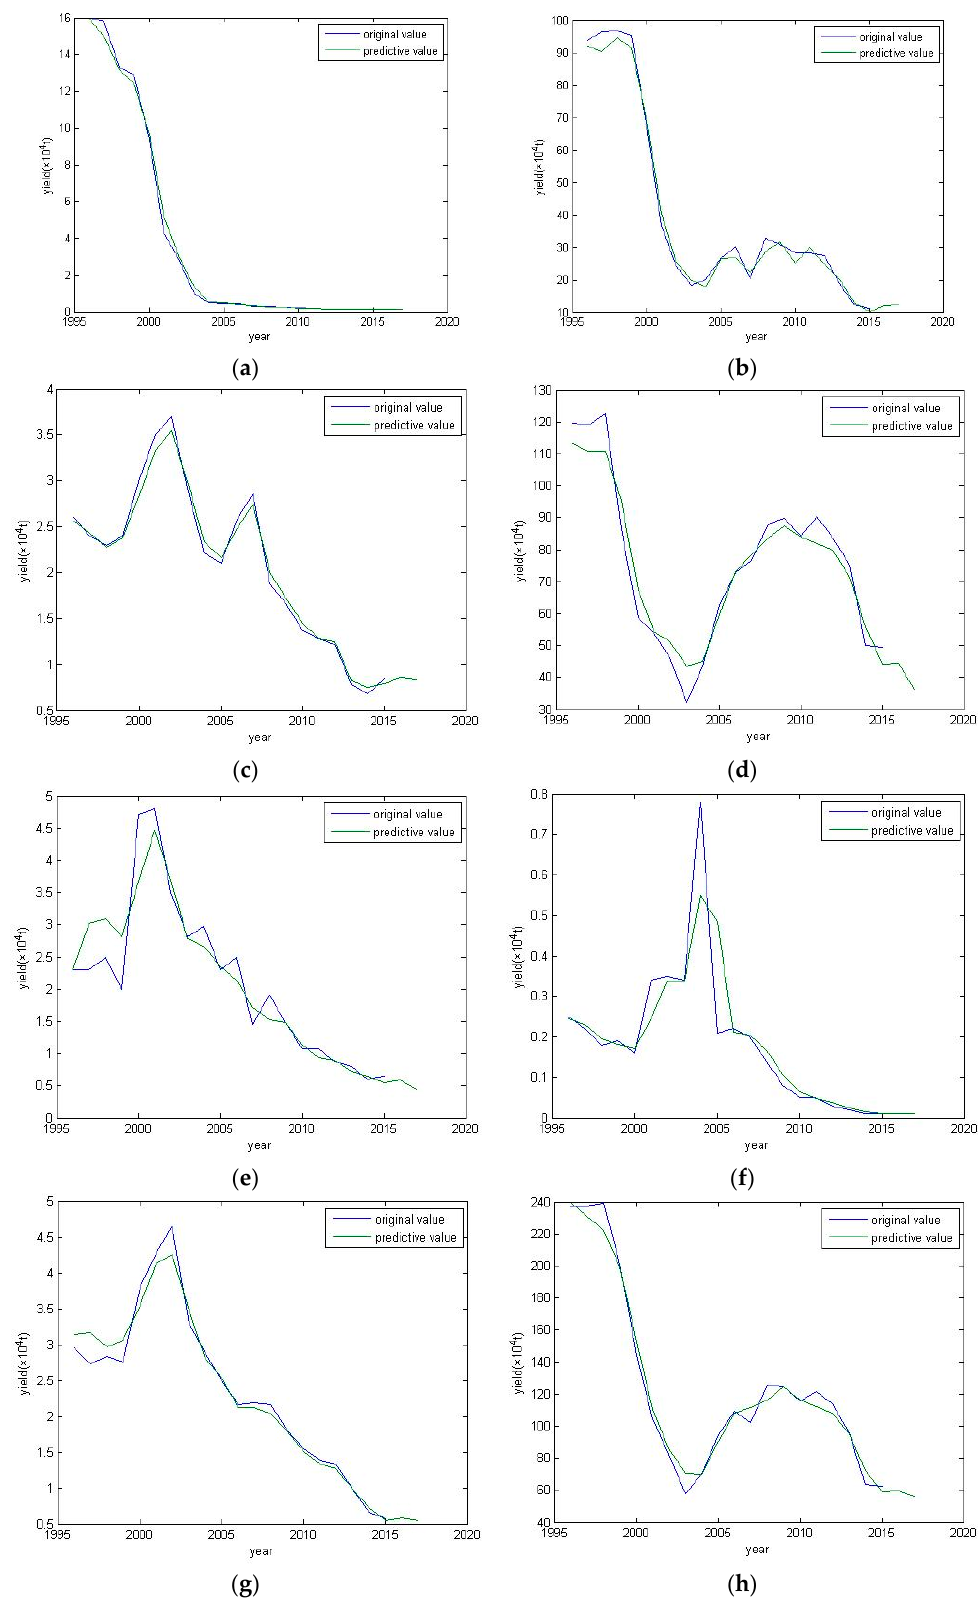
Figure 1. Graph showing crops yield developed from historic data and predicted using the Autoregressive moving average model (ARMA) model in Beijing: ( a ) Rice; ( b ) Wheat; ( c ) Maize; ( d ) Tuber; ( e ) Beans; ( f ) Cotton; ( g ) Peanuts; ( h ) Total grain.